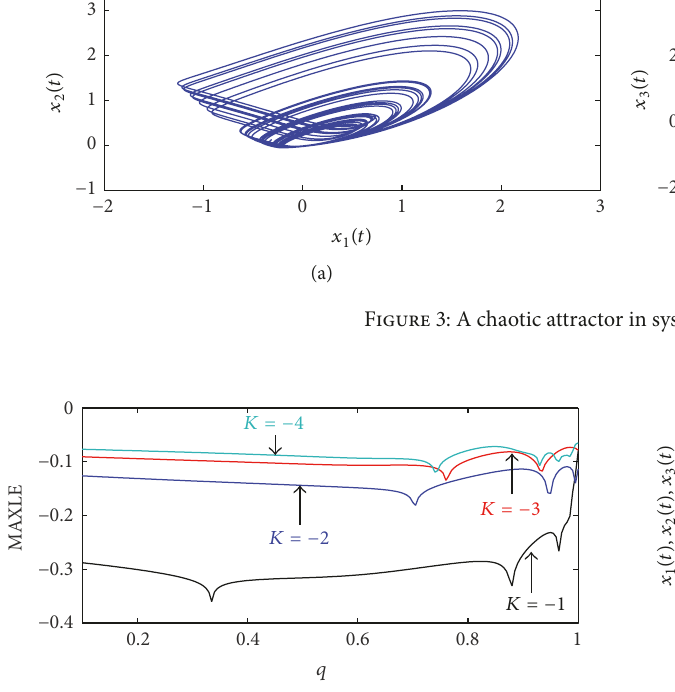
Figure 7: Stabilization of system (7) for 𝑞 = 0.97 and 𝐾 = −3 .